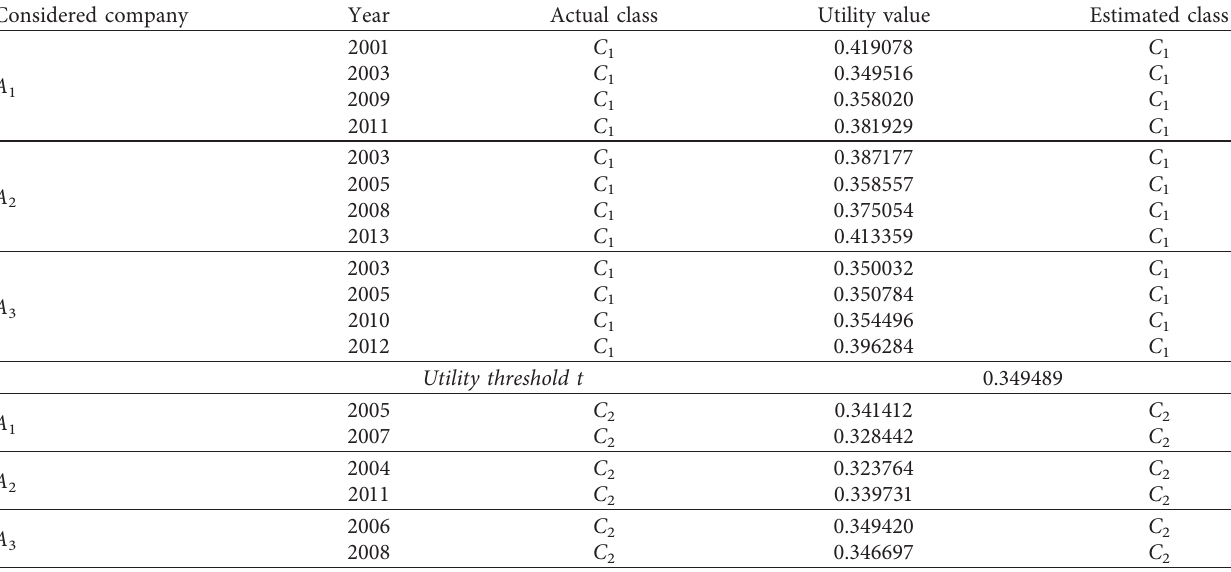
Table 3: Classification results with the SM-UTADIS method (training dataset).